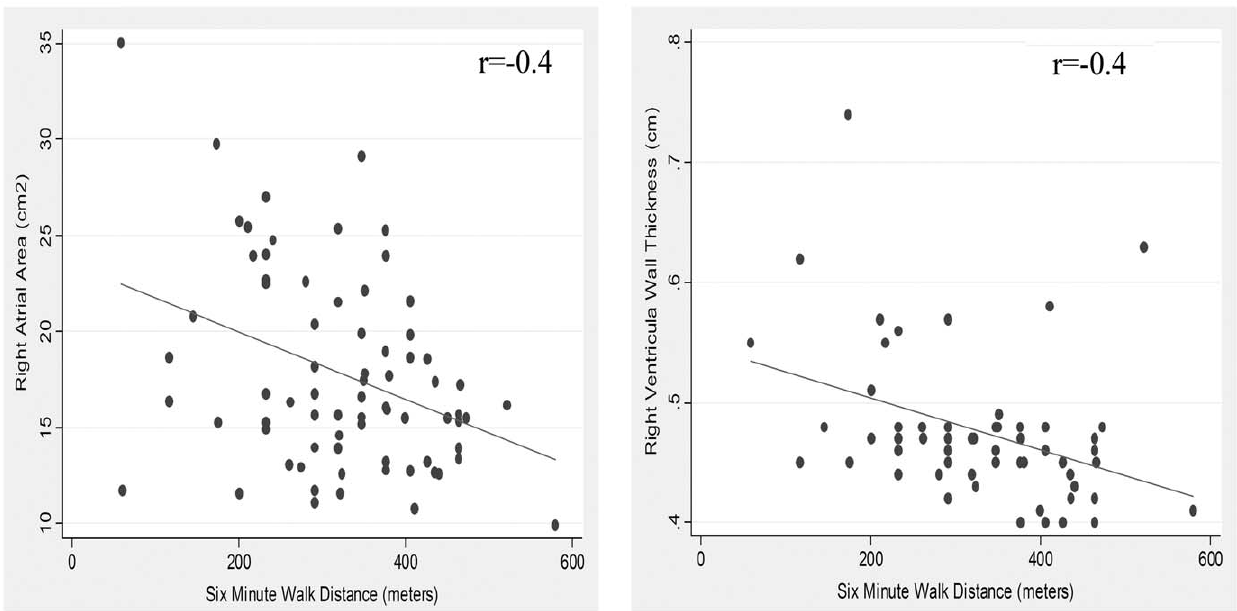
Figure 2. The correlation between right ventricular echocardiographic parameters and six minute walk distance. Panel 2A: The correlation between right atrial area (cm 2 ) and six minute walk distance (meters); (r= 2 0.4, p=0.002). Panel 2B: The correlation between right ventricular wall thickness (cm) and six minute walk distance (meters); (r= 2 0.4, p=0.002). Table 5. Association Between Echocardiogram Parameters and Six Minute Walk Distance.